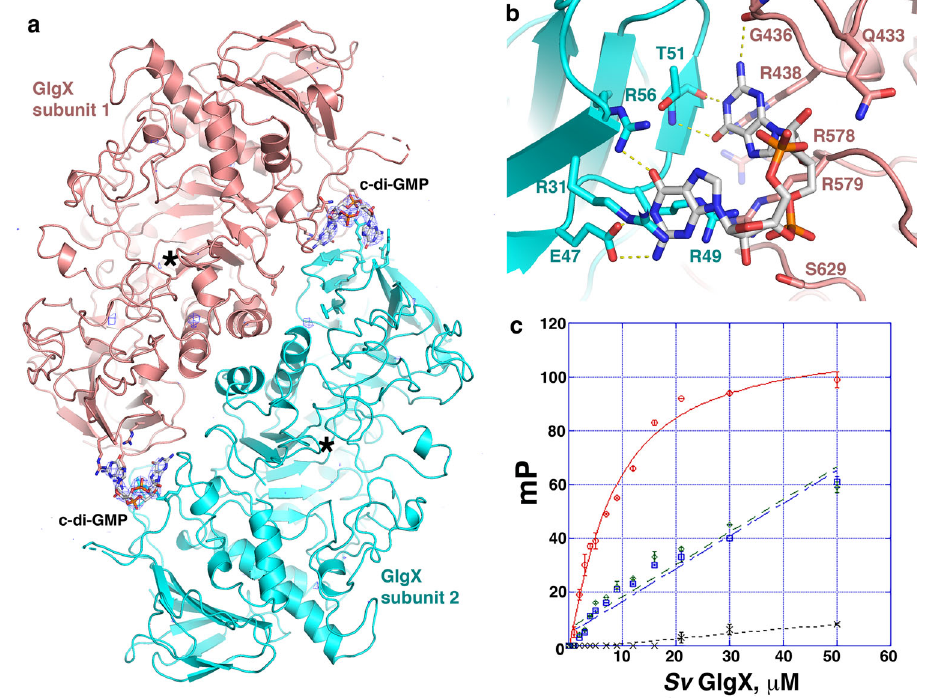
showing interaction of GlgX, GlgX E47A-R49A and GlgX R438A-R579A for F-c-di-GMP in red, green and blue respectively. Also shown is the binding isotherm for GlgX bindingtoF-c-di-AMPinblack.WTGlgX-boundF-c-di-GMPwitha K d of8.2±1.0 μ M whilethemutantsshowednonsaturablebindingandWTGlgXalsodidnotbindF-c- di-AMP. The y -axis and x -axis are millipolarization (mP) units and GlgX concentra- tion ( μ M), respectively. Shown are representative binding curves for each. The experiments were performed in technical triplicates and the error between mea- surementsreported.ErrorbarsrepresentSDofthemeasurements.Sourcedataare provided in the Source data fi